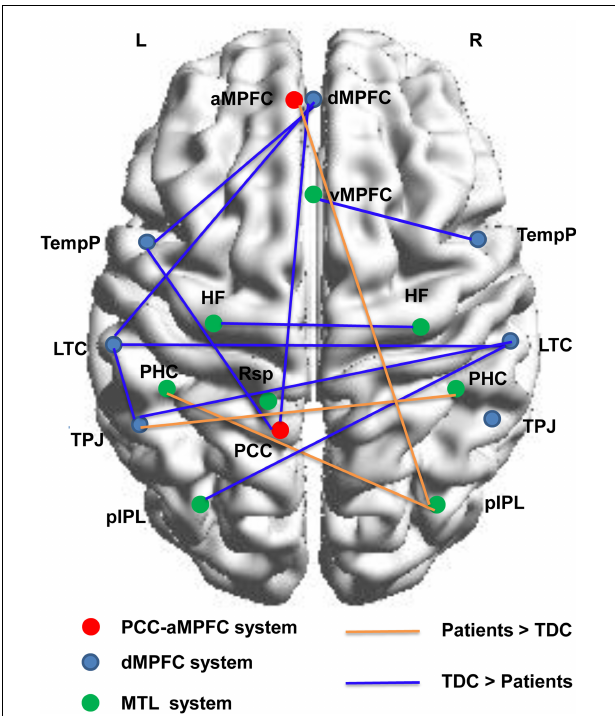
FIGURE 3 | Connected networks in the DMN that showed significant changes of functional connections in the children with GTCS. The orange lines indicate the FC values are increased in the patient group, and the blue lines indicate the FC values are decreased in the patient group. The threshold is set at p < 0.05. L, left hemisphere; R, right hemisphere; TDC, typically developing